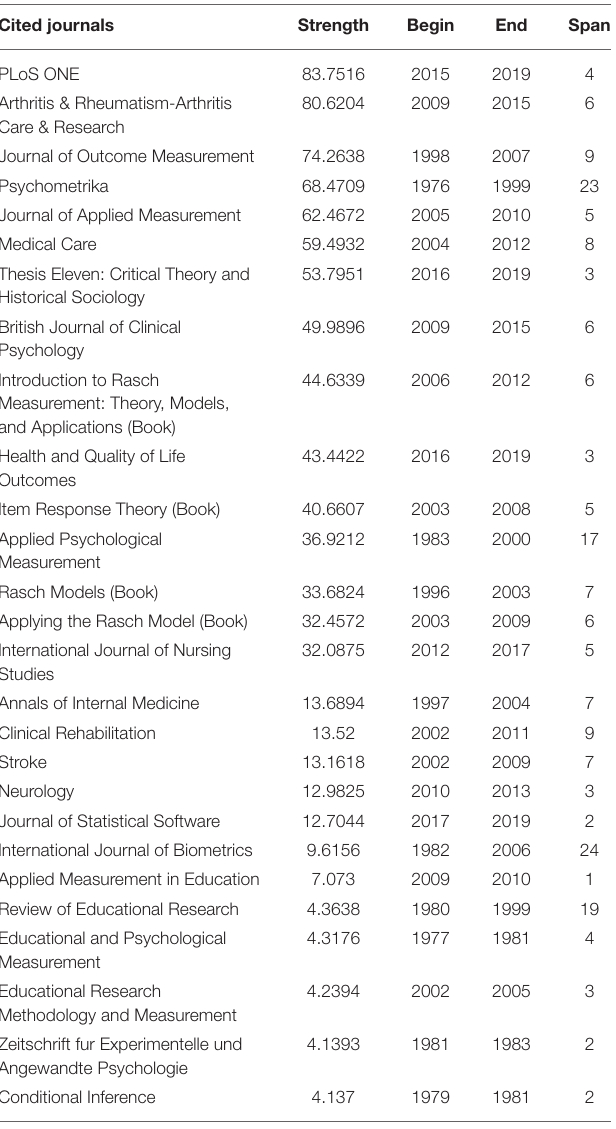
TABLE 4 | Sample publication bursts computed via journal co-citation analysis (JCA).